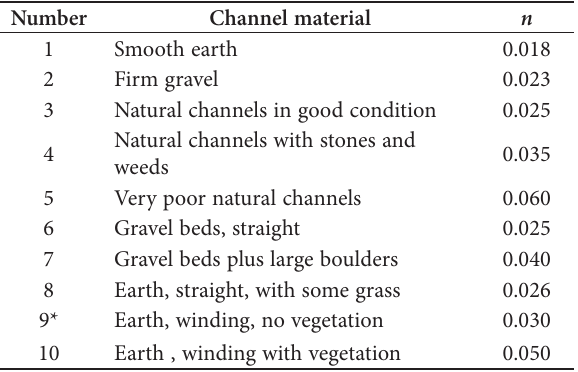
Table 3 . Typical values of Manning roughness coefficient in